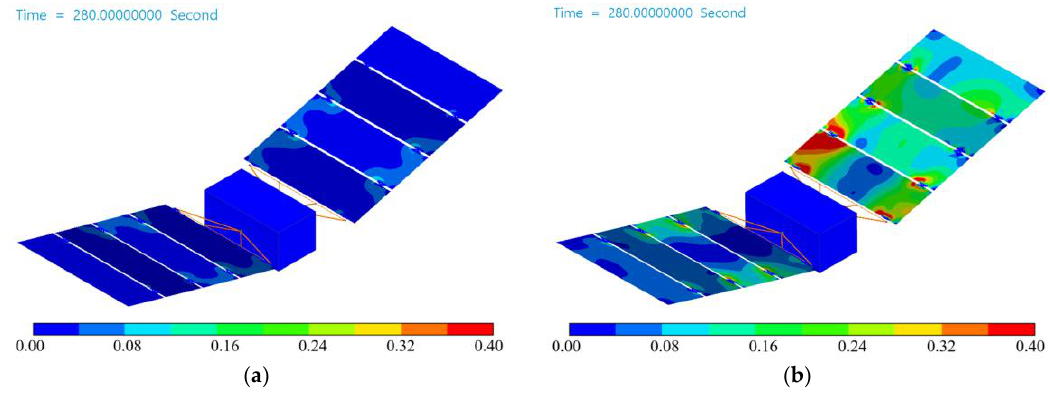
Figure 10. Stress contour of panels in deployment: ( a ) by FEM; ( b ) by